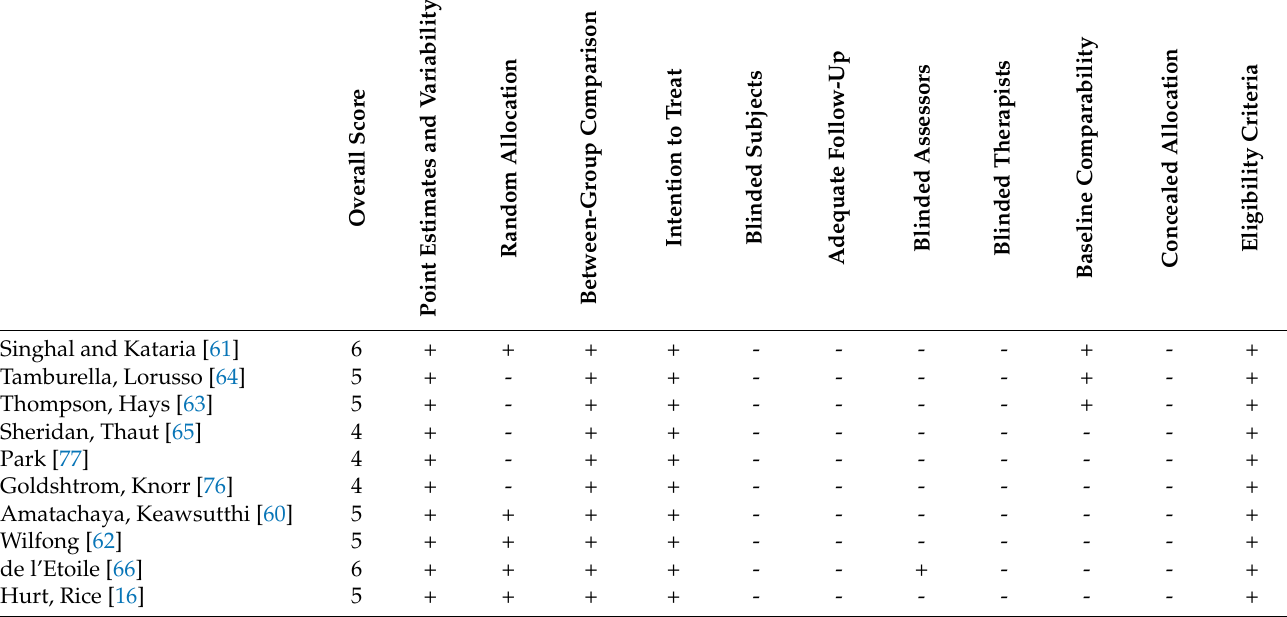
Table 3. Detailed PEDro scoring (+: bias absent, -: bias